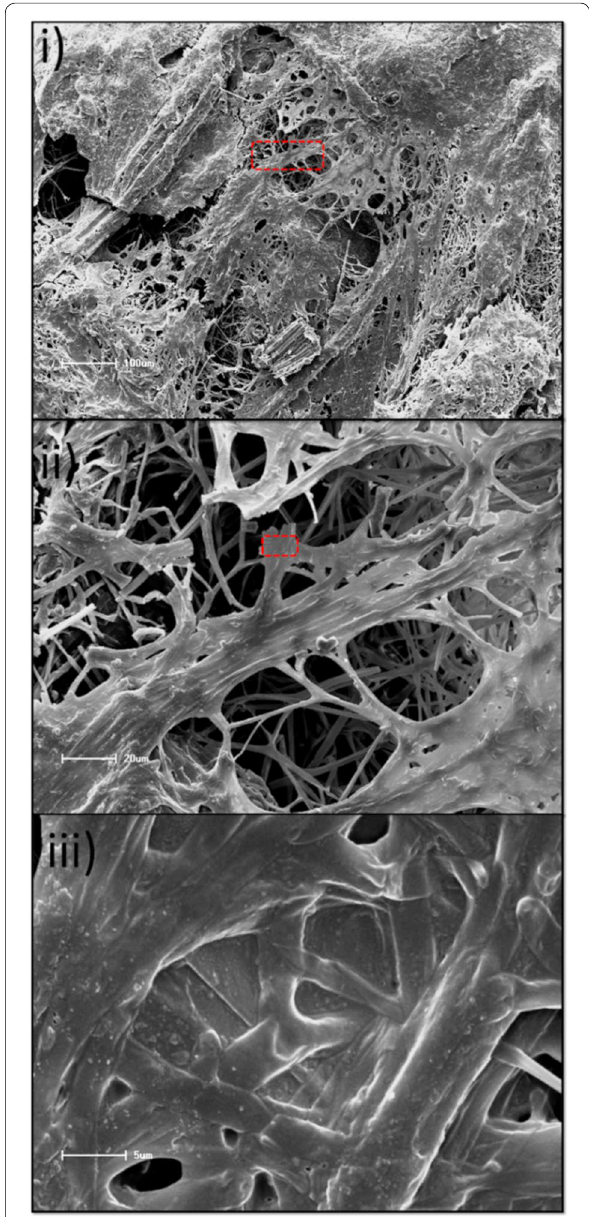
Fig. 6 Scanning electron microscope images of the mycelium-based composite cold-pressed at different resolutions at the same region, the dotted rectangles represent where the zoom was performed and are shown in ii and